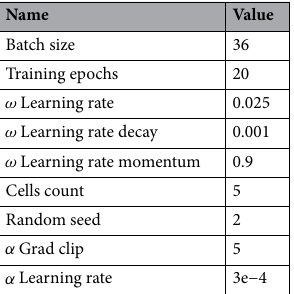
Table 5. Hyperparameters setting for base CNN model